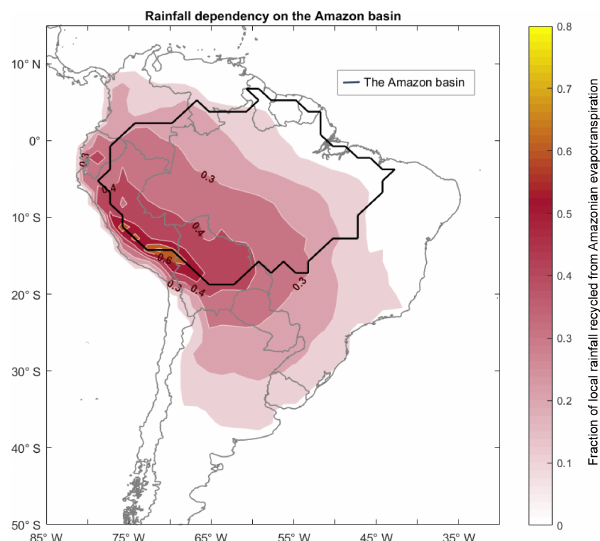
Figure 2. Rainfall dependency on the Amazon basin. The number shows the fraction of local rainfall recycled from Amazonian evap- otranspiration. The yellow areas are among those regions having the greatest sensitivity to Amazonian land use